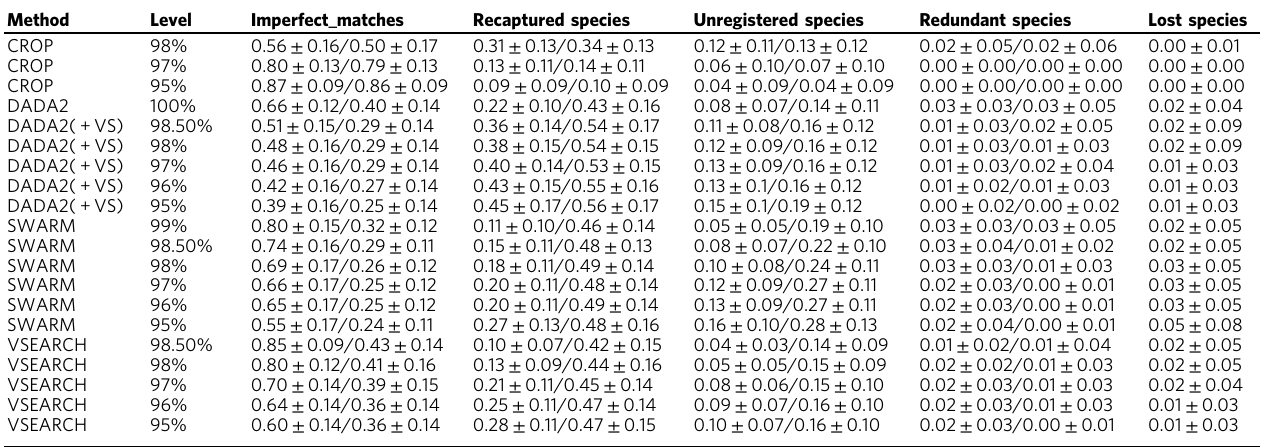
Table 2 Taxonomic composition of OTUs for single sites compared with plant survey data Method Level Imperfect_matches Recaptured species